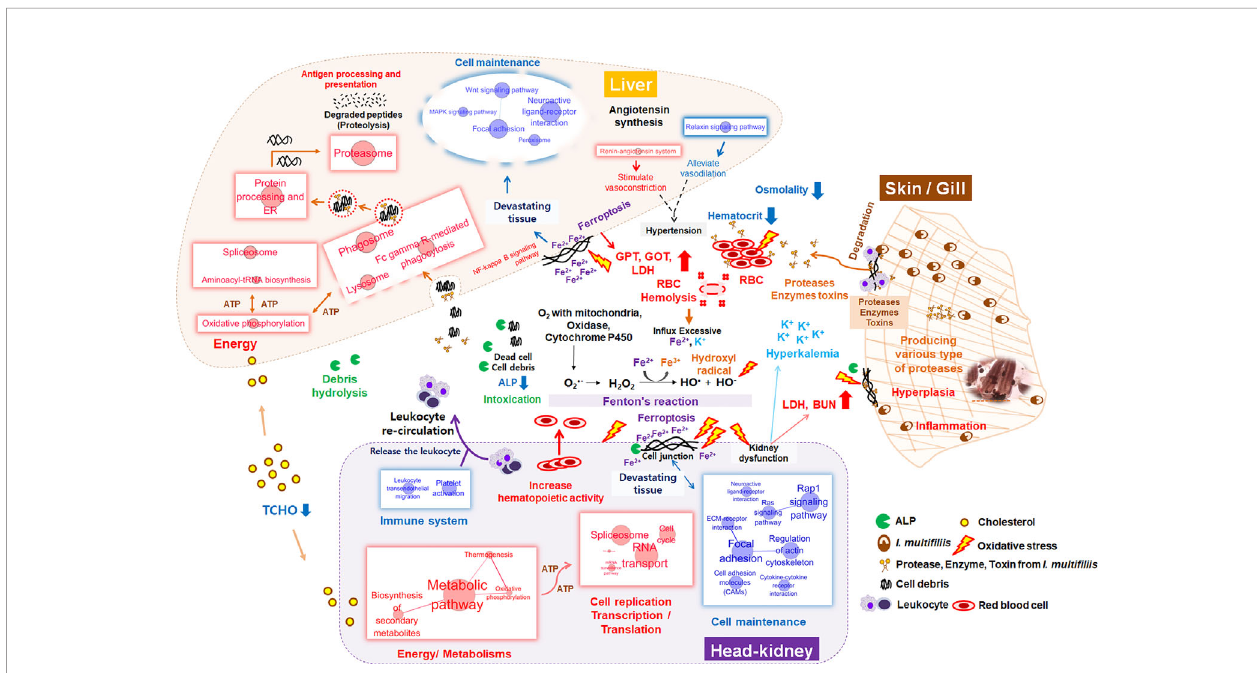
FIGURE 8 | Schematic diagram of systemic changes in the liver, head kidney, blood, and primary infection sites (e.g., gill and skin) during I. multi fi llis infection. The size of red and blue circles with letters represents the number of enriched genes in each KEGG pathway, and edge thickness between two pathways indicates the degree of overlap (biological similarity) during I. multi fi liis